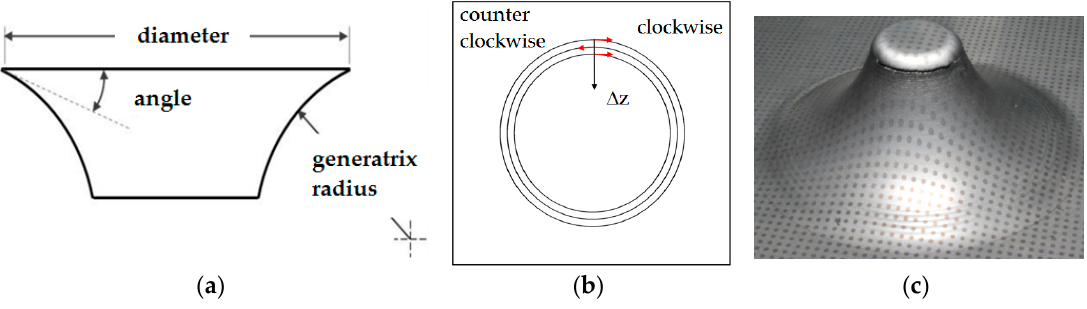
Figure 3. ( a ) Truncated coned geometry, ( b ) tool trajectory and ( c ) final part after testing.